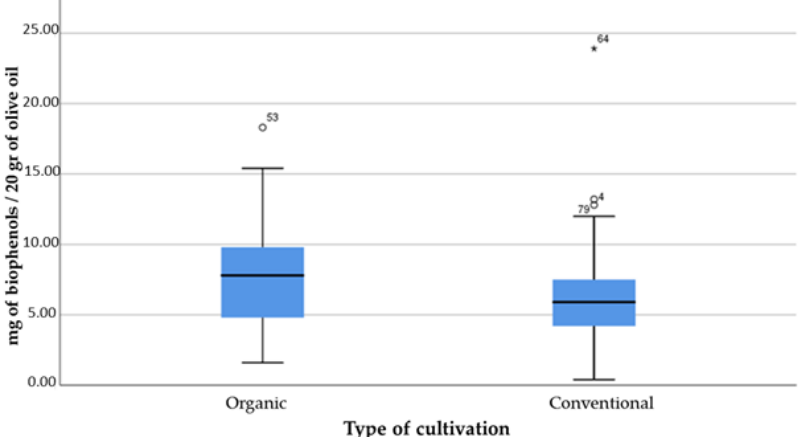
Figure 4. Comparison of biophenol concentrations by the type of cultivation.